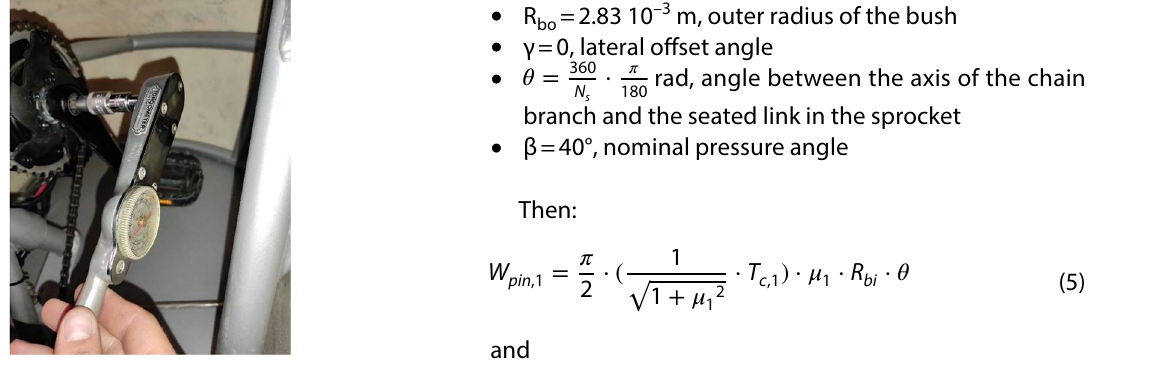
Fig. 12 Experimental set-up to estimate the double-chain transmis- sion efficiency using a torque